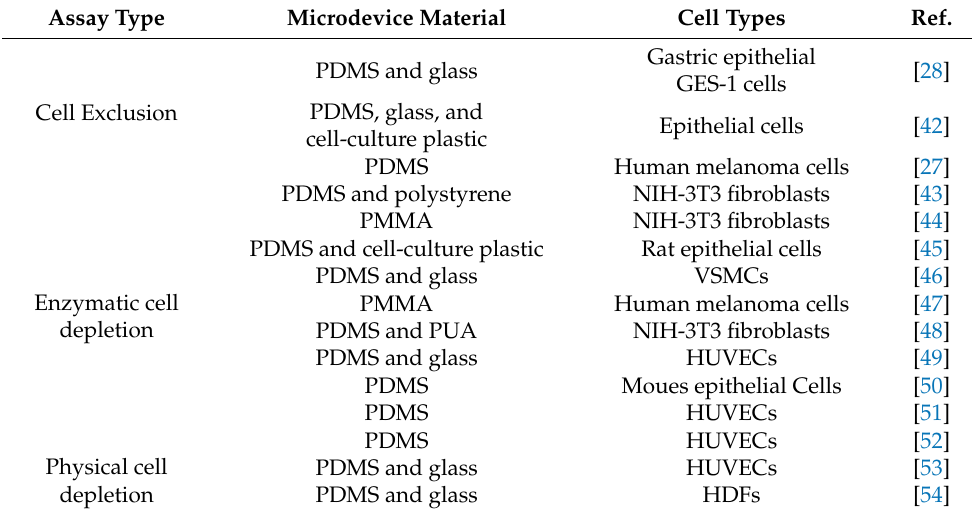
Figure 3. Overview of state-of-the-art microfluidic wound healing assays, including cell-depletion (physical or enzymatic) and physical cell exclusion approaches in microfluidic channels. ( A ) the mechanical cell depletion approach, ( B ) the enzymatic cell depletion approach, and ( C ) the cell exclusion approach. In each approach cross-section, and top views of the microchannel during and after wounding are illustrated. Table 1. Assay types, material of devices, and cell types for wound healing